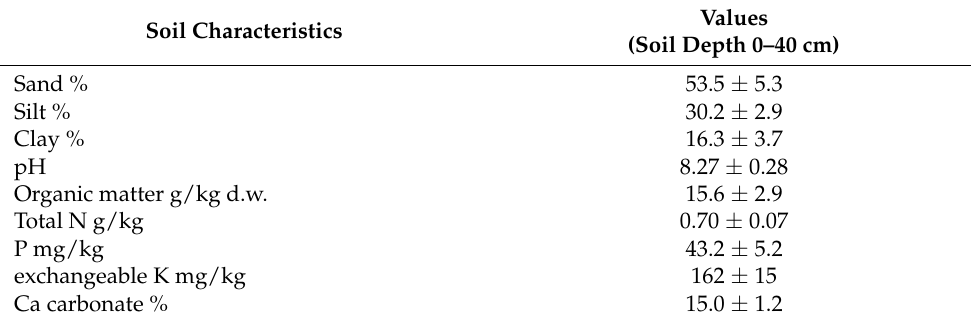
Table 2. Soil properties in the experimental vineyard at the beginning of the trial. Data are the average of 3 replicates (soil samples) ± standard